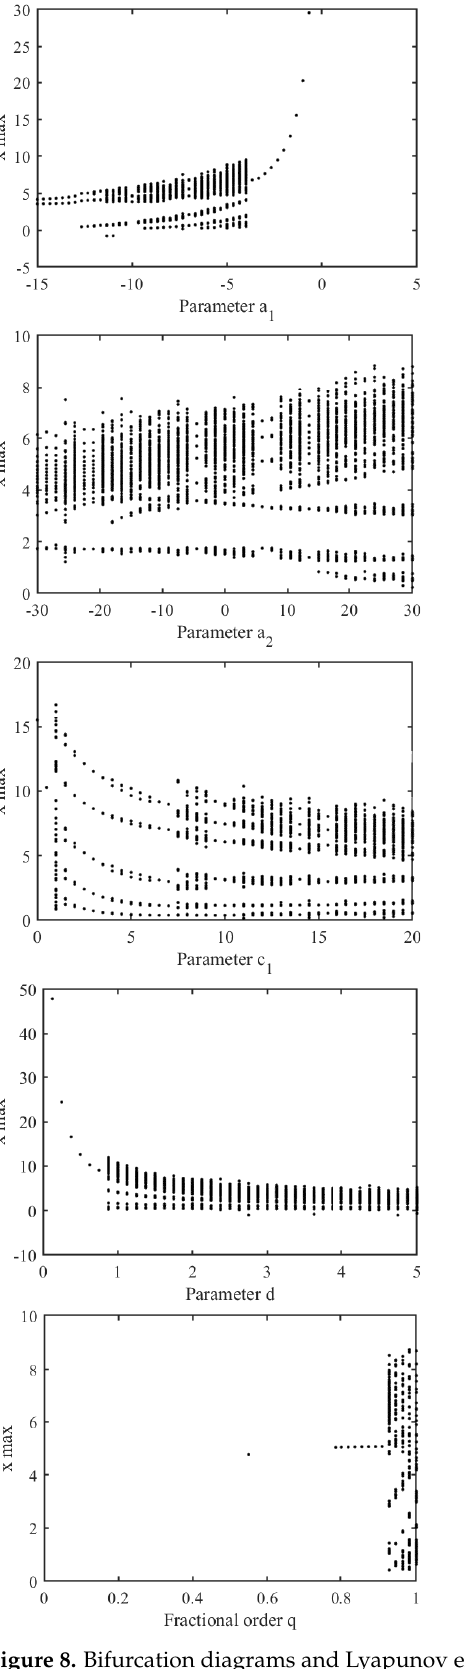
Figure 8. Bifurcation diagrams and Lyapunov exponents spectra of the optimized fractional-order system (2), using parameters a 1 , a 2 , c 1 , d and fractional-order q , for the IWO-optimized